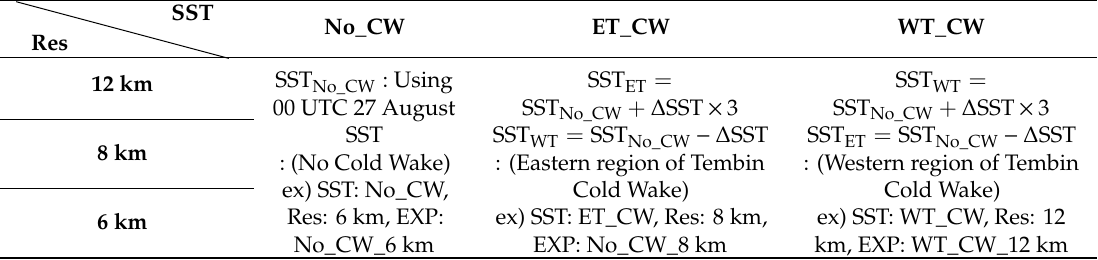
Table 1. The experimental design used in this